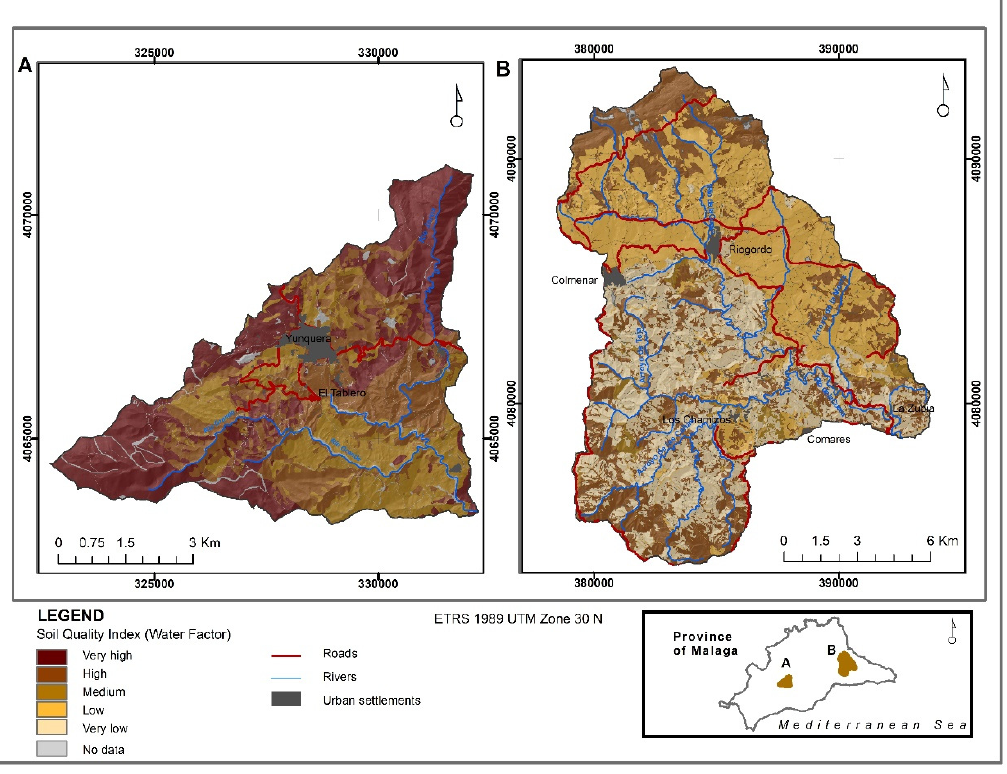
Figure 2. Water factor in the soil quality index. Maps show the spatial distribution of each category of soil quality according to water indicators in ( A ) GR and ( B ) BE.